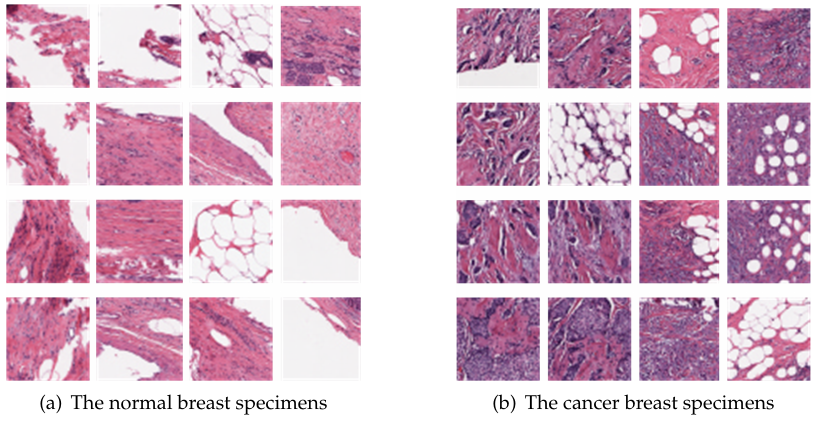
Figure 3. The experimental samples for